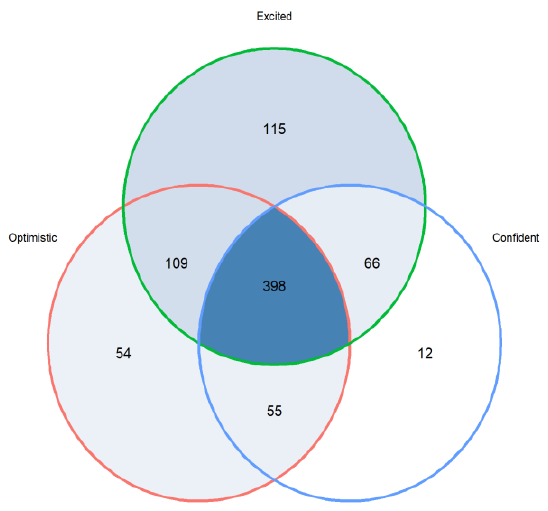
Figure 1. Positive emotions expressed (i.e., strongly agree or agree) by 809 of the 993 participants in the BREATHE study recruited between October 2021 and March 2022.